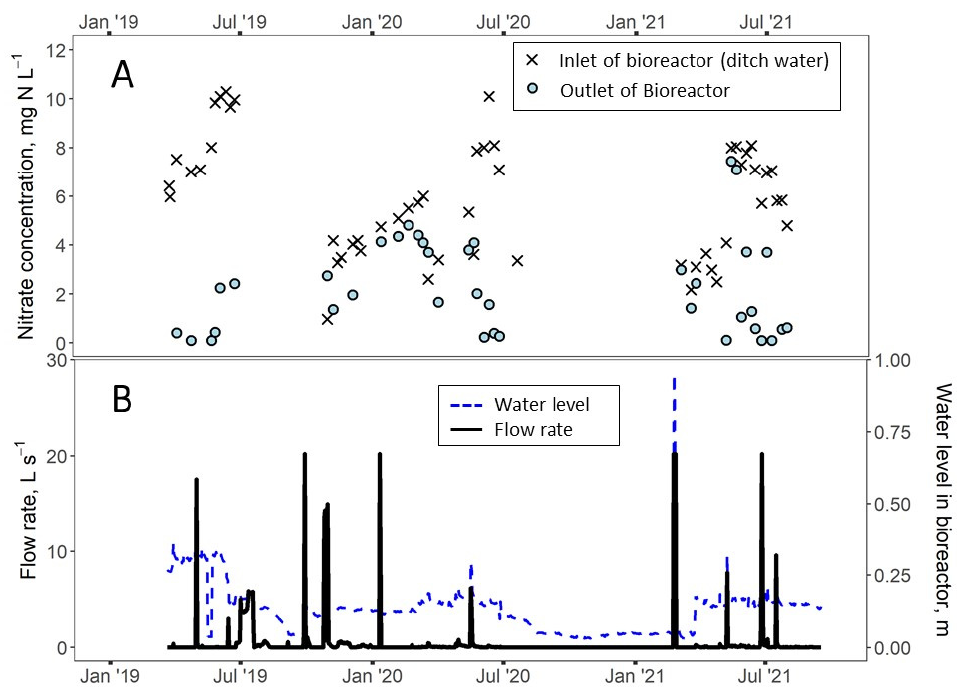
Figure 3. Nitrate concentrations at the bioreactor inlet (black × , note these are the same as in Figure 2A) and bioreactor outlet (light blue circle) of the diversion bioreactor ( A ). Estimated flow rate (solid black line) and measured water level (dashed blue line) in the outlet control structure ( B ).